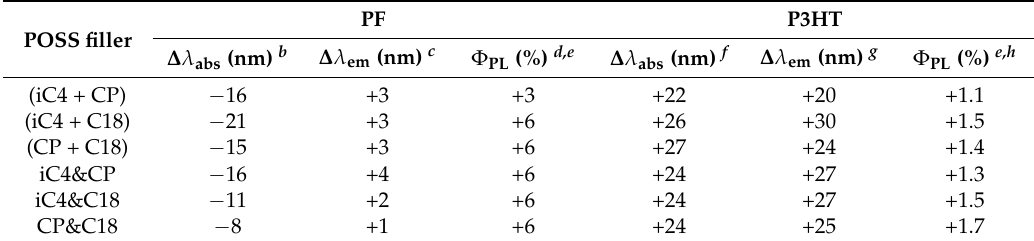
Table 1. Optical property changes by hybrid formation with POSS a .